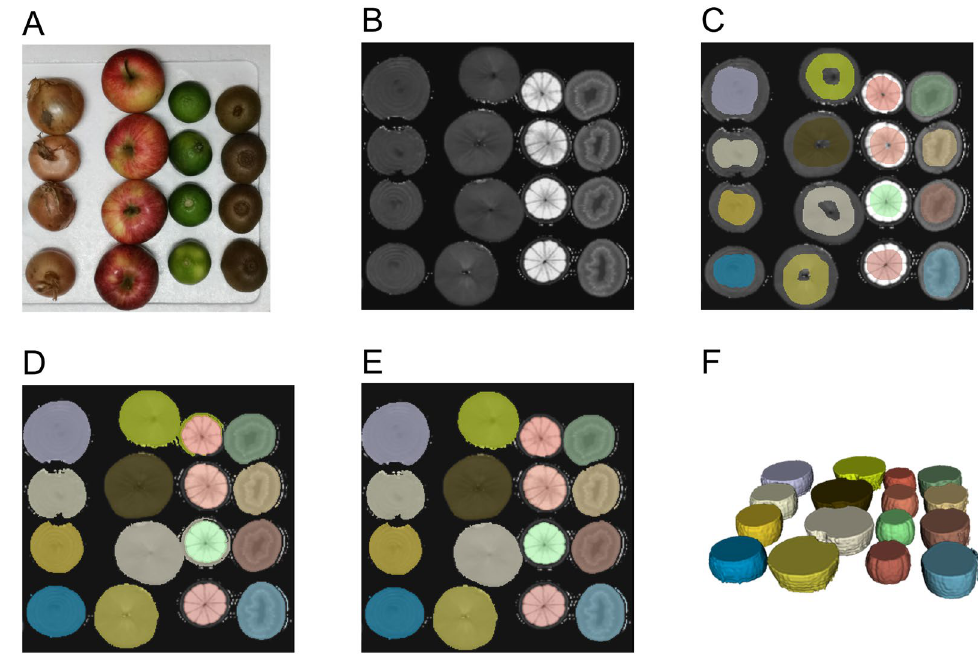
Figure 6. Phantom design and workflow of semi-automatic segmentation. The phantom ( A ) and the workflow of semi-automatic segmentation are shown exemplarily for T2-weighted turbo-spin-echo acquisition ( B – E ). On the original image ( B ), we manually defined preliminary volumes of interest ( C , diameter 1.5 cm). The growth from seeds algorithm was used to augment the 3D volumes ( D ) with subsequent manual correction of erroneous border segment sections ( E ). In F a representative 3D volume rendering is